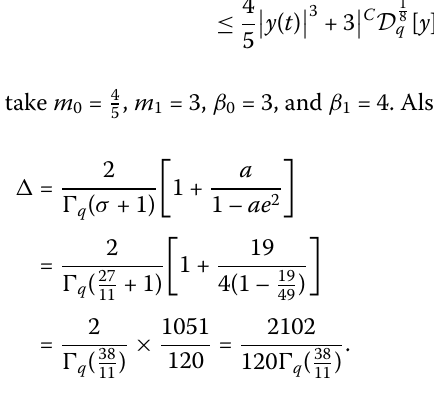
for y , z ∈ R . Then we